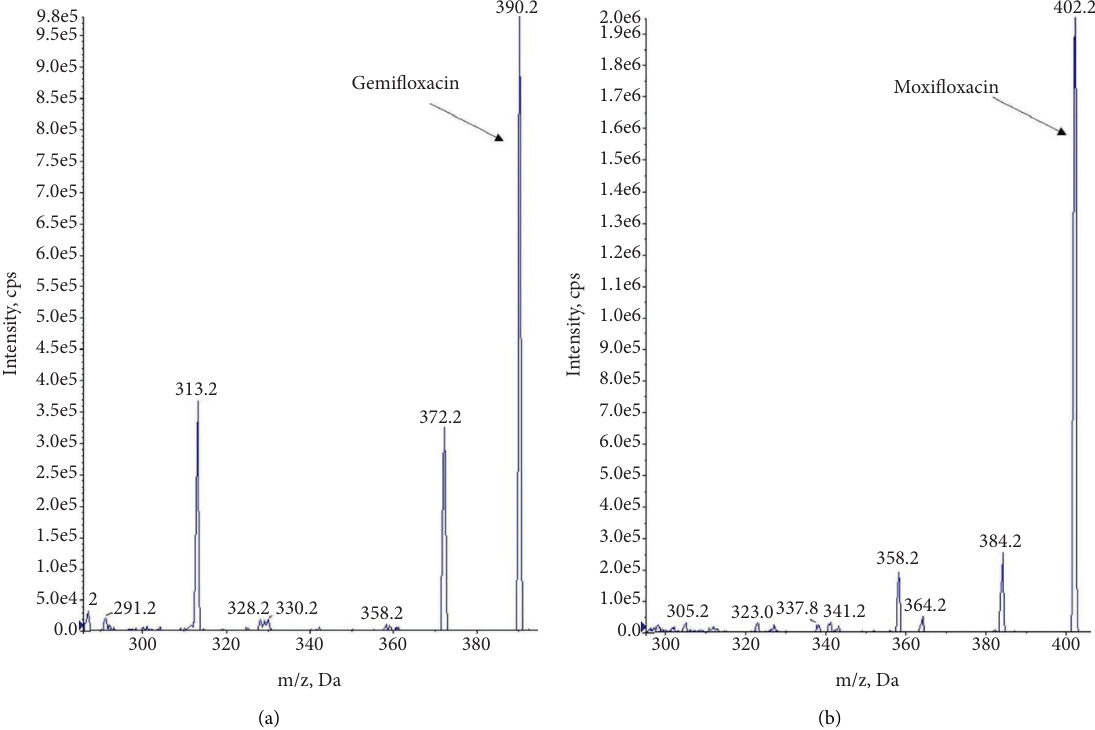
Figure 2: Product ion mass spectra of (a) gemifoxacin and (b) moxifoxacin (internal